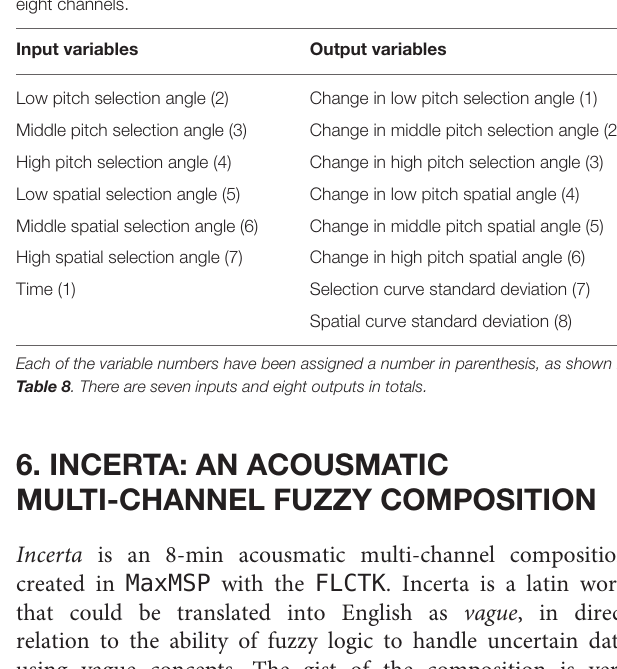
TABLE 7 | Input and output variables for Incerta , an acousmatic composition for eight